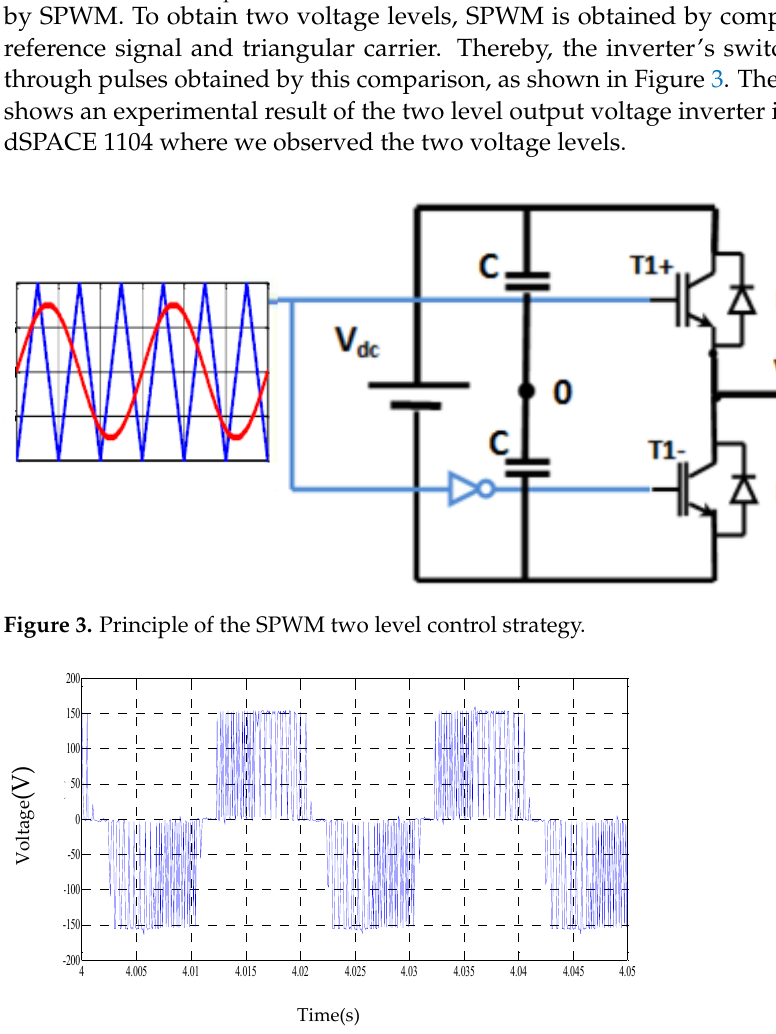
Figure 4. Output voltages of the two level inverter.